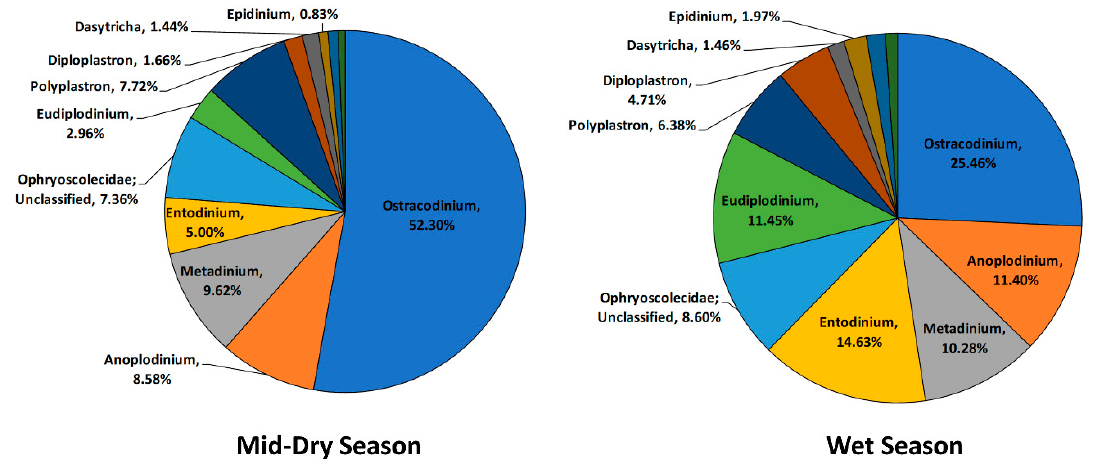
Figure 4. Taxonomic composition of the rumen protozoa community at genus level for the mid-dry and wet seasons in un-supplemented animals.